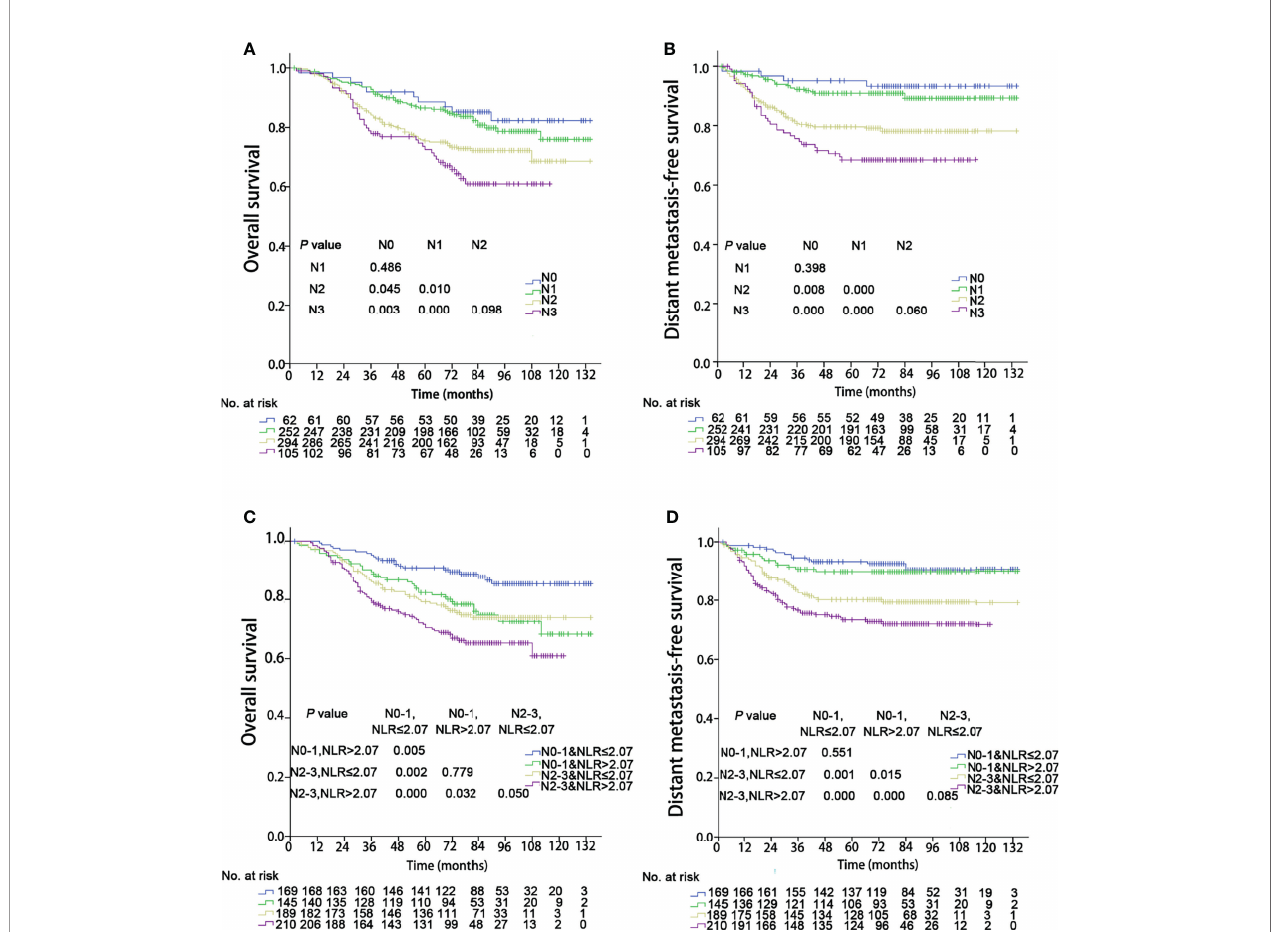
FIGURE 3 | Kaplan – Meier survival curves of 713 patients strati fi ed by the N and N & NLR classi fi cations. NLR, Neutrophil-to-lymphocyte ratio. (A, C) Overall survival; (B, D) Distant metastasis failure-free survival.